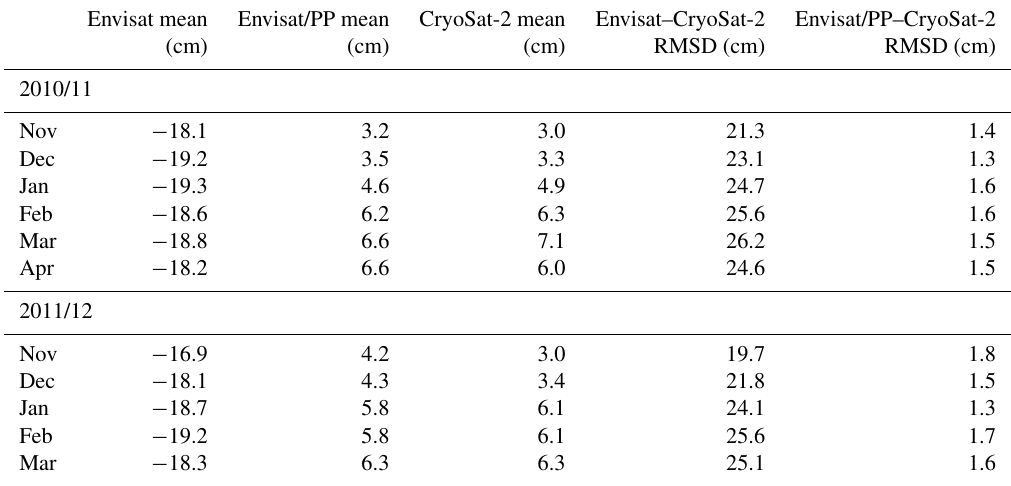
Table 1. Monthly mean Envisat, Envisat/PP and CryoSat-2 circumpolar radar freeboard estimates and monthly mean circumpolar RMSD between Envisat and CryoSAt-2 and between Envisat/PP and CryoSat-2. Envisat mean Envisat/PP mean